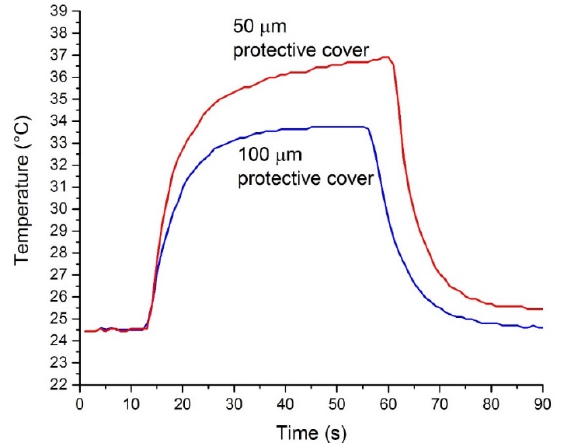
Figure 7. Outlet temperature at the constant water flow and constant power of 20 W for the structures with different thicknesses of protective LTCC layers.